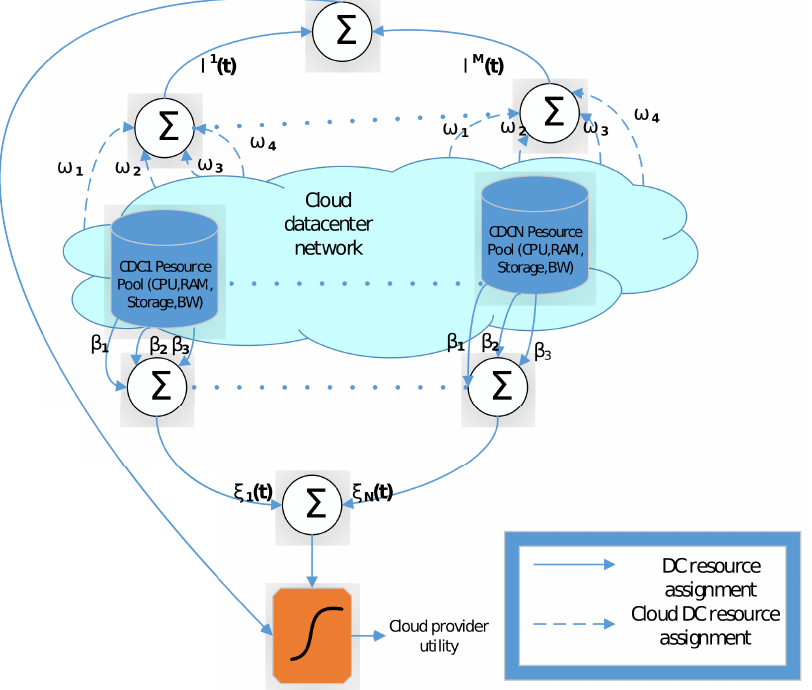
Figure 3. Schematic diagram of calculating cloud provider utility